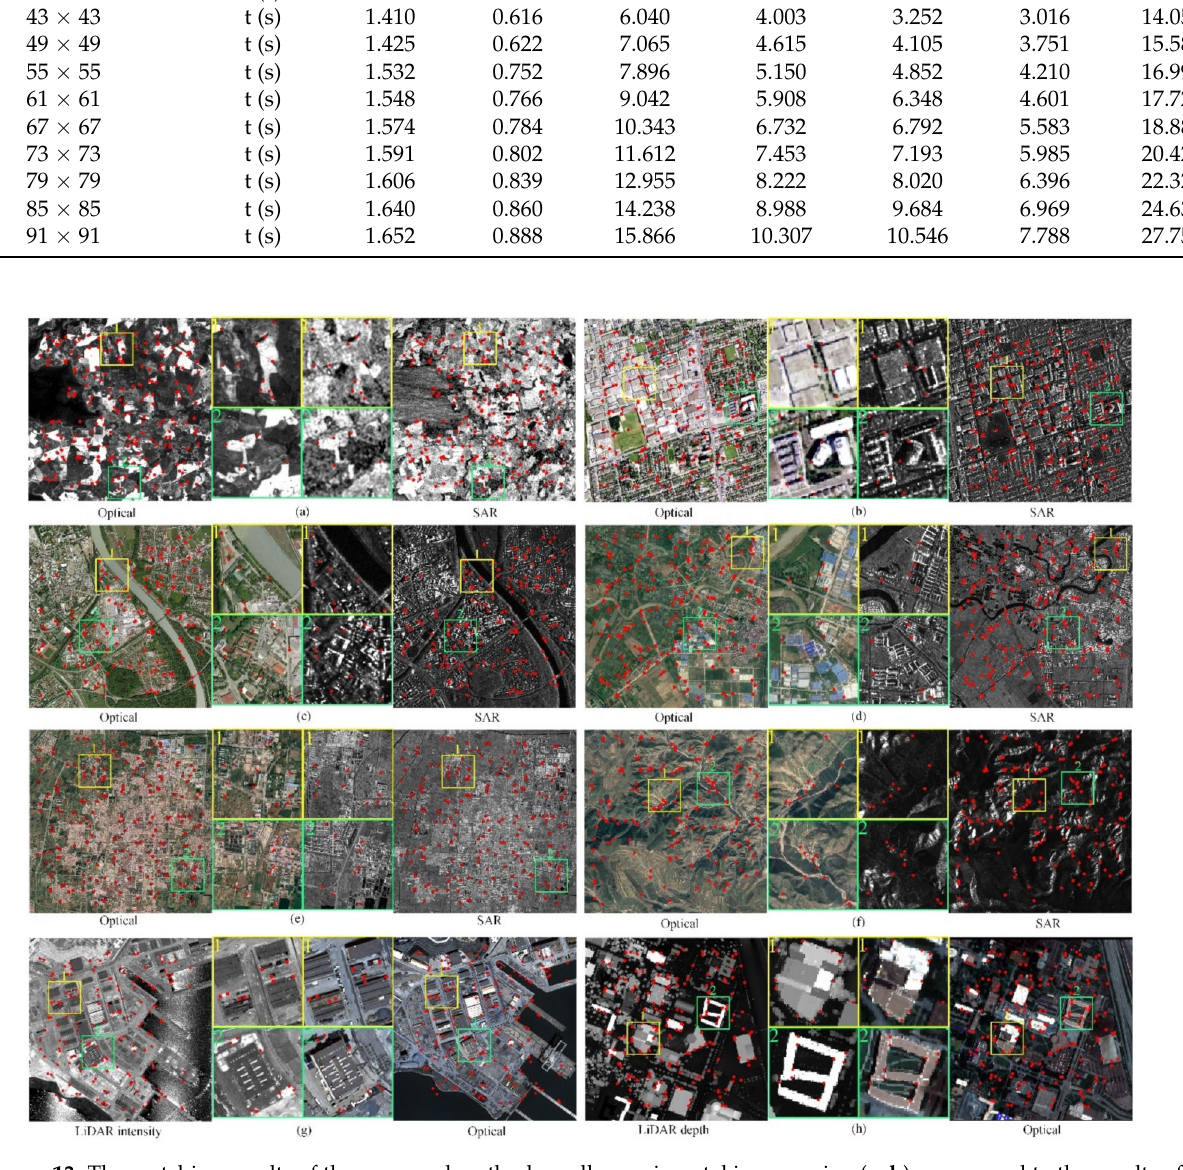
Figure 13. The matching results of the proposed method on all experimental image pairs. ( a – h ) correspond to the results of image pairs